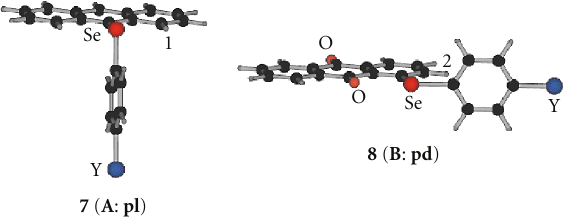
Scheme 4: Illustration for the structures of 7 ( A : pl ) and 8 ( B : pd